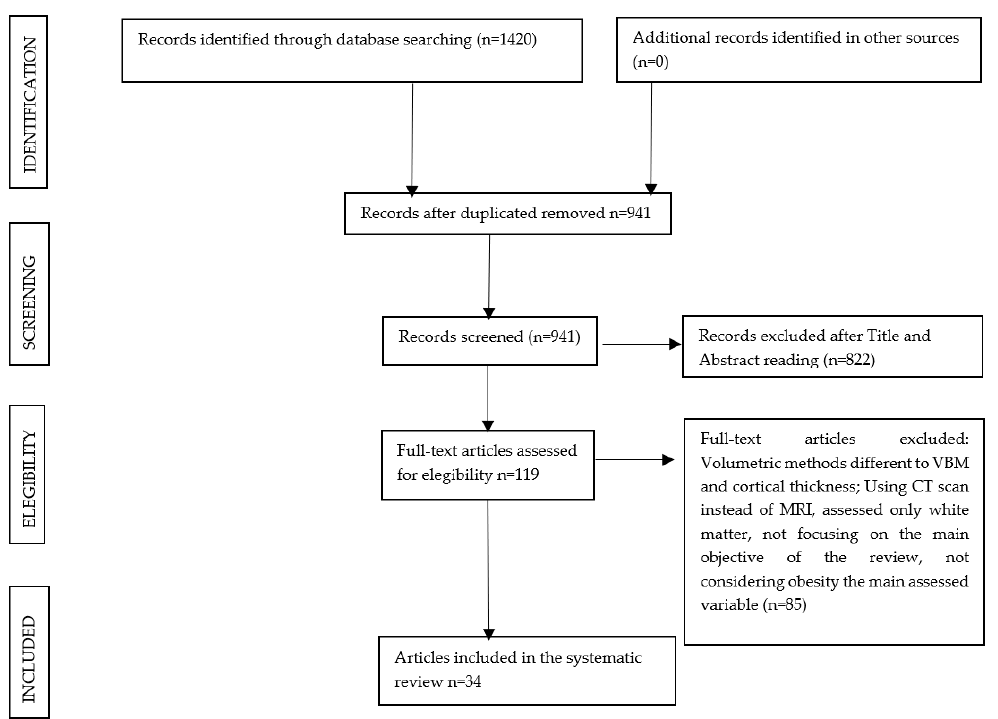
Figure 1. Flowchart of the search process for the systematic review.